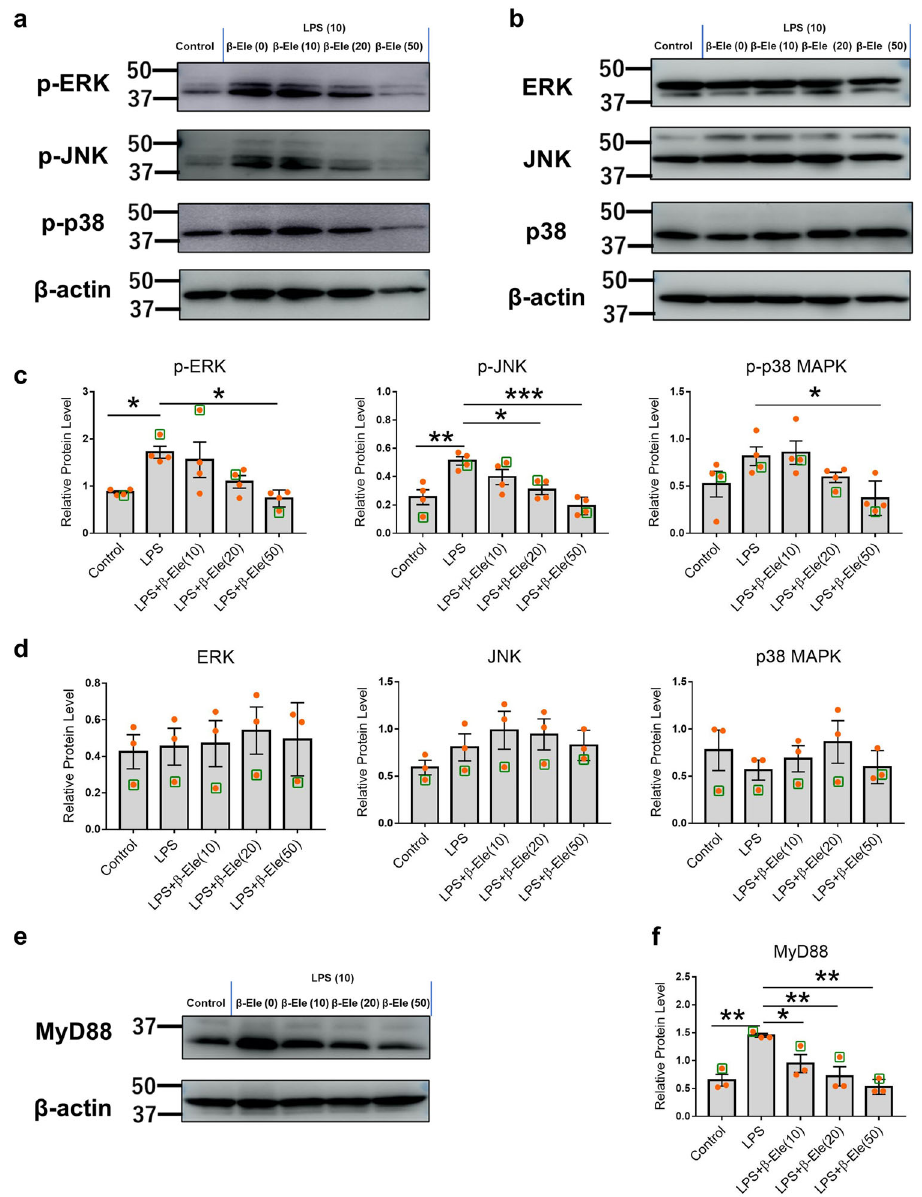
Fig. 8 Anti-in fl ammatory pathways of β -elemene. a , b Immunoblotting of phosphorylated ( a ) and unphosphorylated ( b ) p42 ERK, p46 JNK, p38 MAPK, and β -actin in RAW 264 cells ( β -actin was the internal control). c The protein levels of p-ERK, p-JNK, and p-p38 MAPK ( n = 4). d The protein levels of ERK, JNK, and p38 MAPK ( n = 3). e Immunoblotting of MyD88 and β -actin in RAW 264 cells ( β -actin was the internal control). f Protein level of MyD88 ( n = 3). LPS: the concentration of LPS was 10 μ g/ml in the RAW 264 cell culture system. LPS + β -Ele (0, 10, 20, and 50 μ g/ml): LPS (10 μ g/ml) and 0, 10, 20, and 50 μ g/ml β -elemene were added to the RAW 264 cell culture system. The data of representative fi gures in a , b , and e were showed in green boxes. The results are shown as the mean ± SEM. * p < 0.05, ** p < 0.01, *** p < 0.001 versus LPS group assessed using one-way ANOVA followed by Dunnett ’ s multiple comparisons. The results represent one of three independent